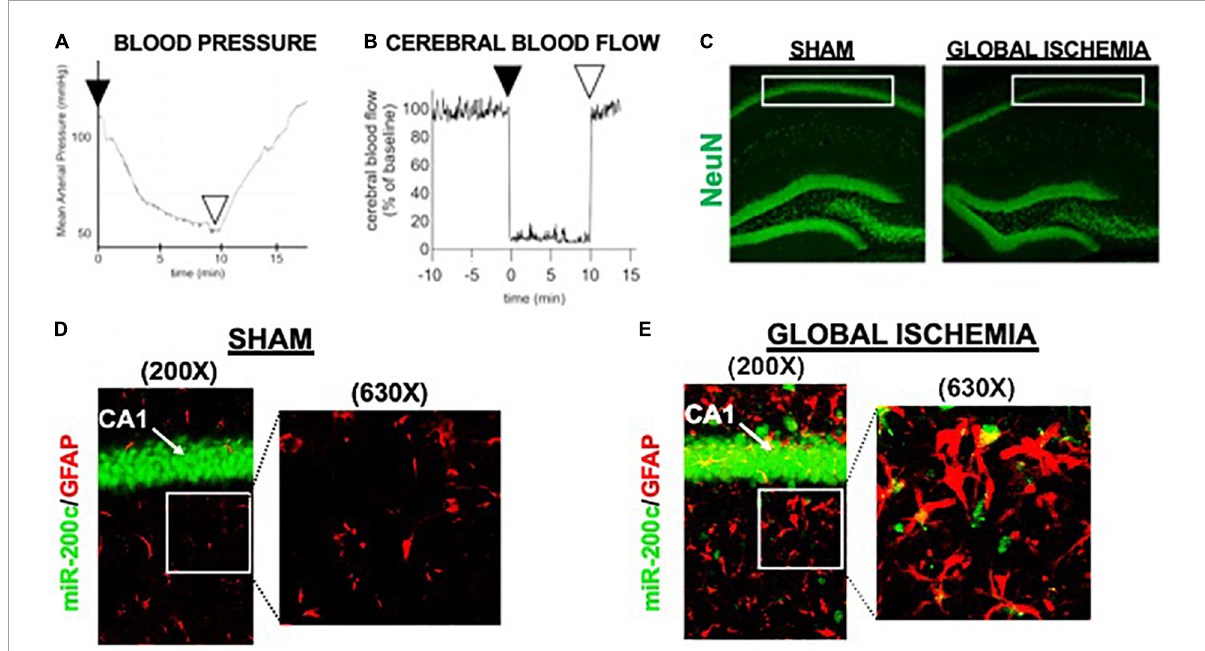
FIGURE1 Mouse global cerebral ischemia model. Invasive blood pressure monitoring (A) and laser doppler cerebral blood flow measurement (B) during bilateral carotid artery occlusion (2 vessel, 2VO) plus 5% isoflurane-induced hypotension. (C) Representative image of fluorescent immunohistochemical (IHC) labeling for neurons (NeuN, green) in mouse hippocampus 7 days after global cerebral ischemia. Note post-injury reductions in NeuN+ cells in cornu ammonis-1 (CA1) sub-region (boxed). (D,E) Representative images of CA1 labeled for the astrocyte marker glial fibrillary acidic protein (GFAP, red) complexed with fluorescent in situ hybridization for miR-200c (green) expression. Note augmented miR-200c expression in astrocytes 7 days after global cerebral ischemia (E)